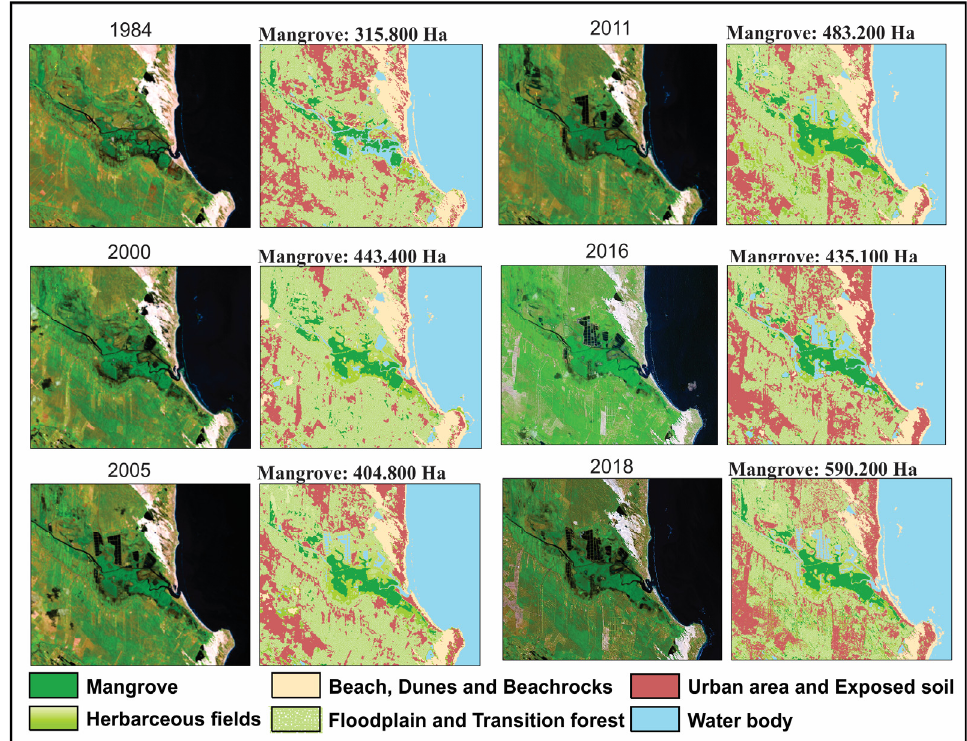
Figure 3. Multitemporal analysis between 1984 and 2018. Area calculations were performed for each class derived from the unsupervised classification.